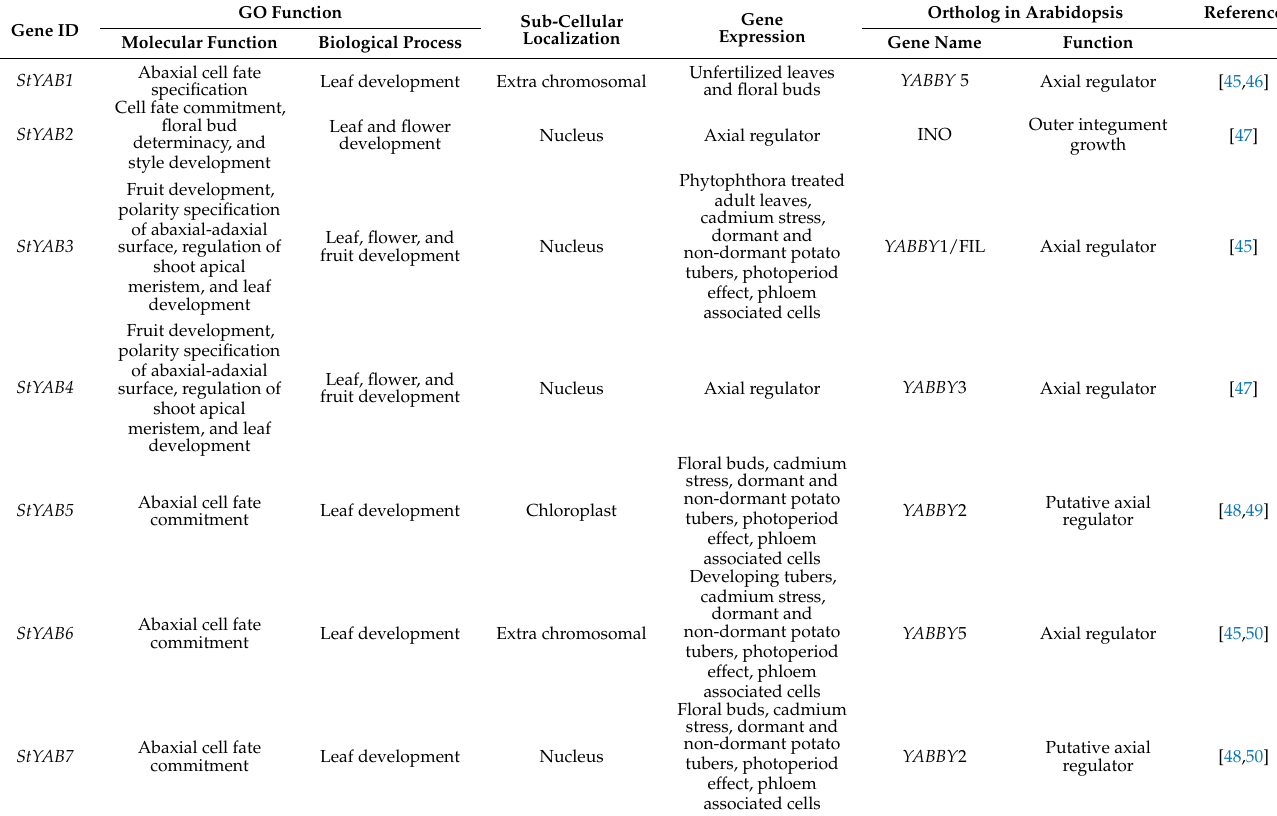
Table 2. Gene ontology enrichment analysis of StYAB genes their GO functions, sub-cellular localization signal genes expression, orthologs in arabidopsis, and their functions are presented in the table.